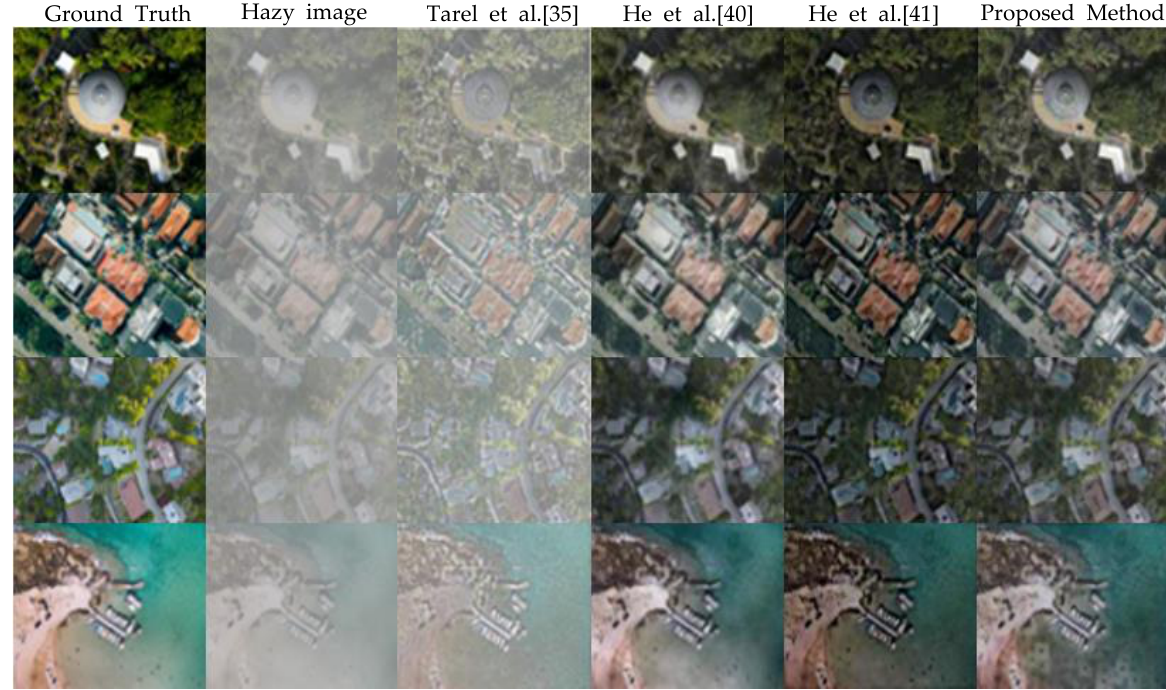
Figure 7. Comparative test results of different dehazing methods using NH-HAZE dataset with Tarel and Hautiere [35], He et al. [40], He et al. [41], and the proposed method.